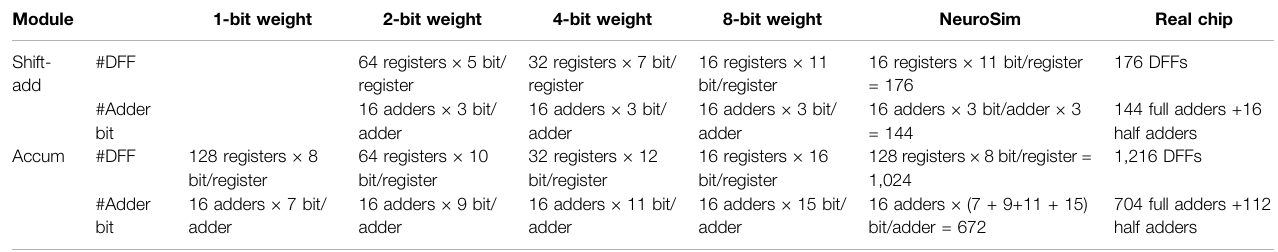
TABLE 4 | Shift-add and accumulator settings for recon fi gurable precision.